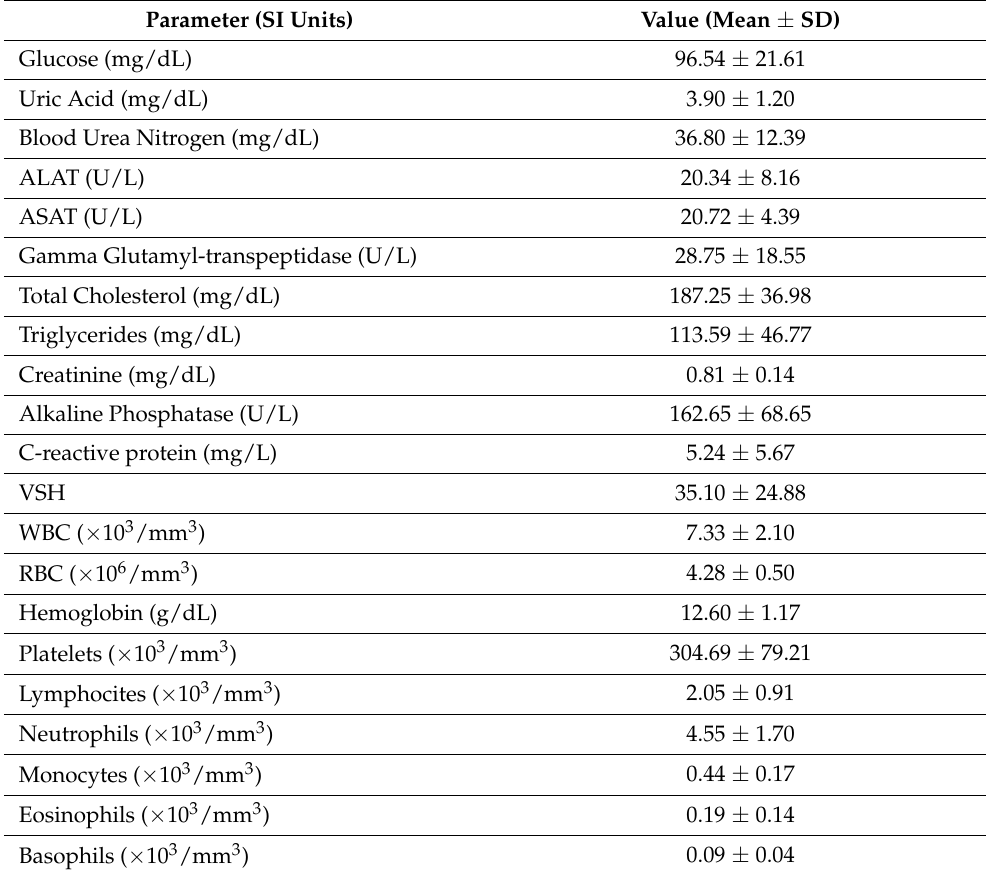
Table 1. Biochemical and haematological profiles of the patients included in the